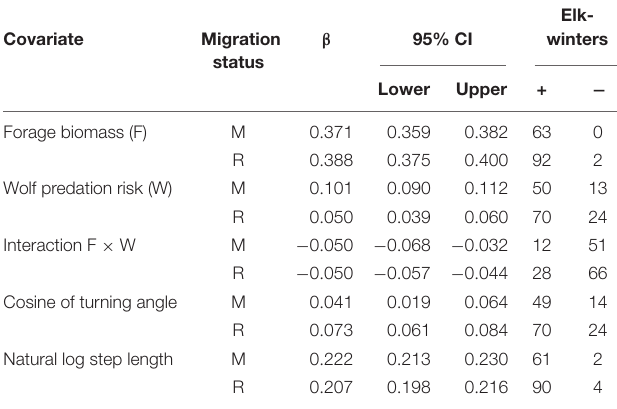
TABLE 1 | Population-level standardized selection coefficients and frequency of their +/ − direction for individual female elk for forage biomass (F), wolf resource selection (W), Forage by Predation interaction (F × W), turn angle and natural log of step length for migrant (M) and resident (R) elk derived using integrated Step Selection Approach at the Ya Ha Tinda winter range adjacent to Banff National Park, Alberta, Canada, during winters from 2002–2003 to 2015–2016.